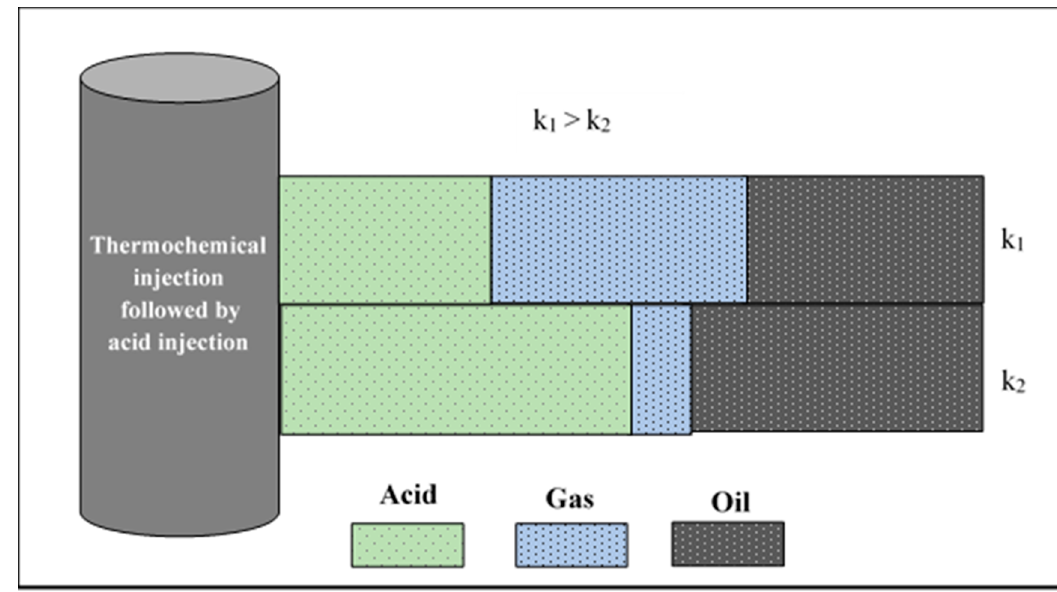
Figure 18. Acid diversion using thermochemical approach.